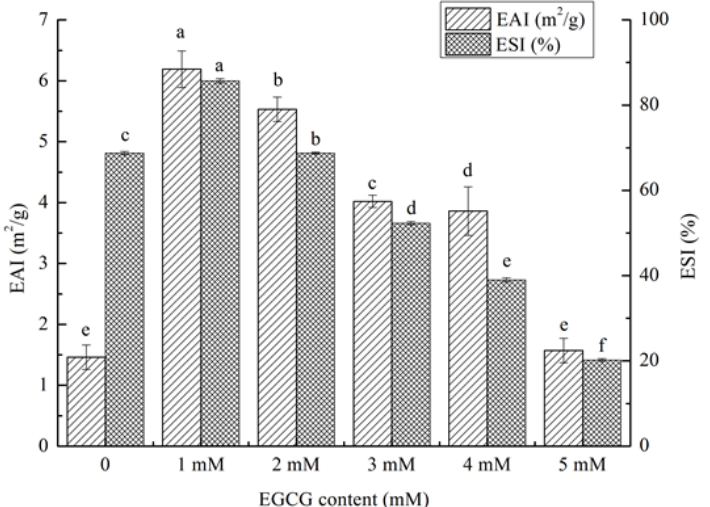
Figure 5. (a–f) Emulsifying properties of HPI and covalent HPI-EGCG complexes at EGCG con- centrations of 1, 2, 3, 4, and 5 mM (EAI is the Emulsifying Activity Index and ESI is the Emulsify- ing Stability Index).